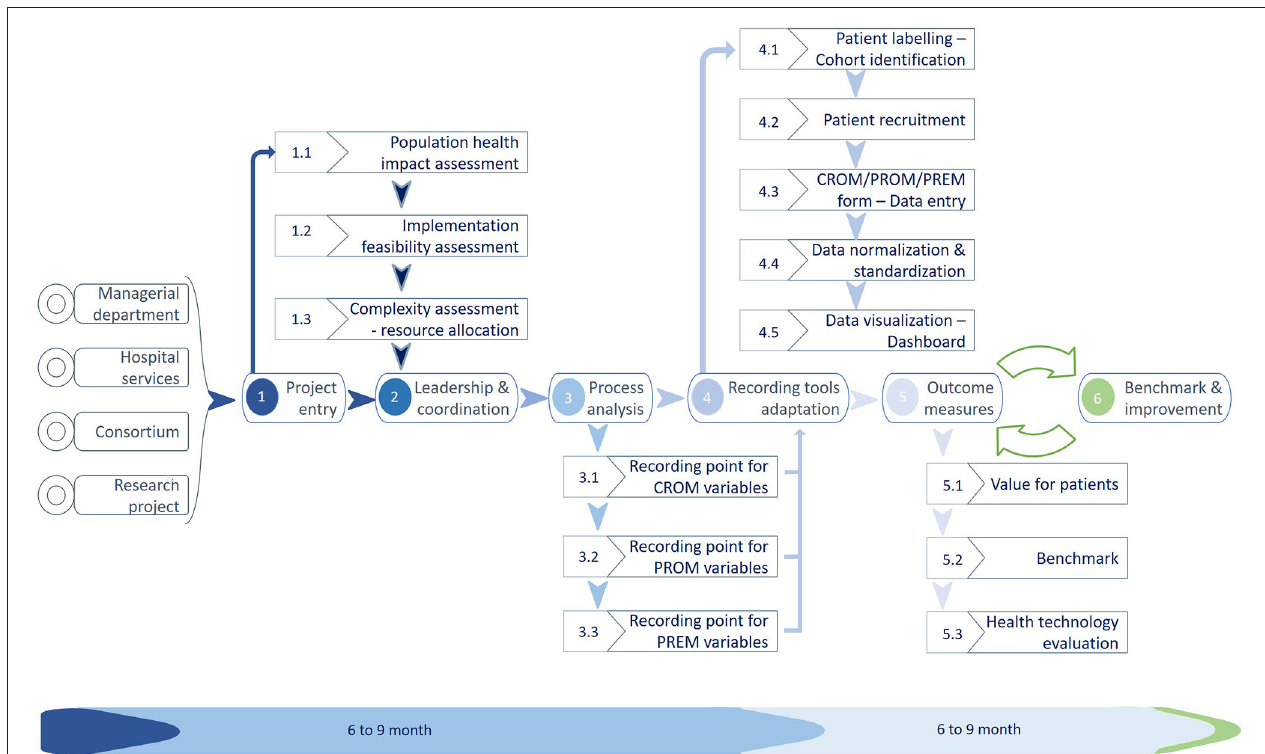
FIGURE 2 | Implementation of the VBHC project process. During the first 12 months, approximately the institution should have settled the tools necessary to begin the data recording with enough quality routinely in the daily work (Icons credits: